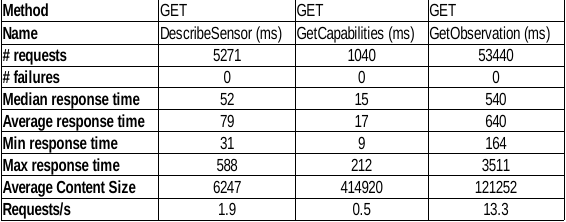
Table 5. PM test results with 100 users (using istSOS-proxy).